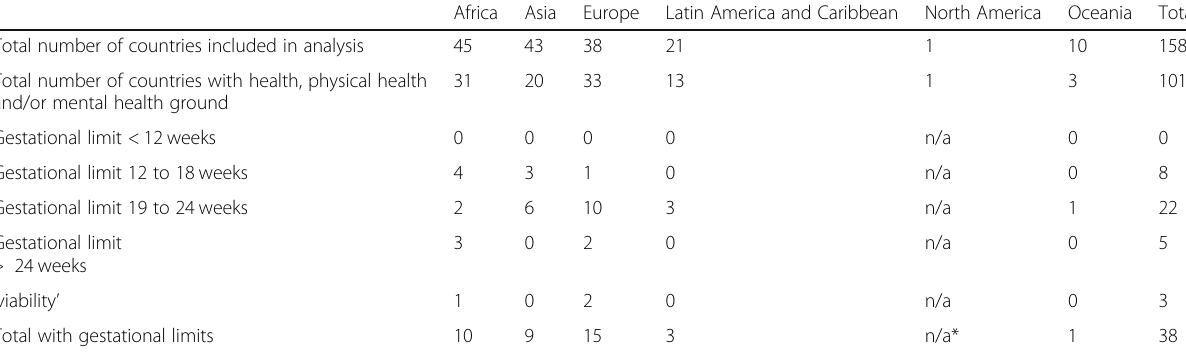
Table 2 Regional data: Health, physical health and/or mental health ground and associated gestational limits